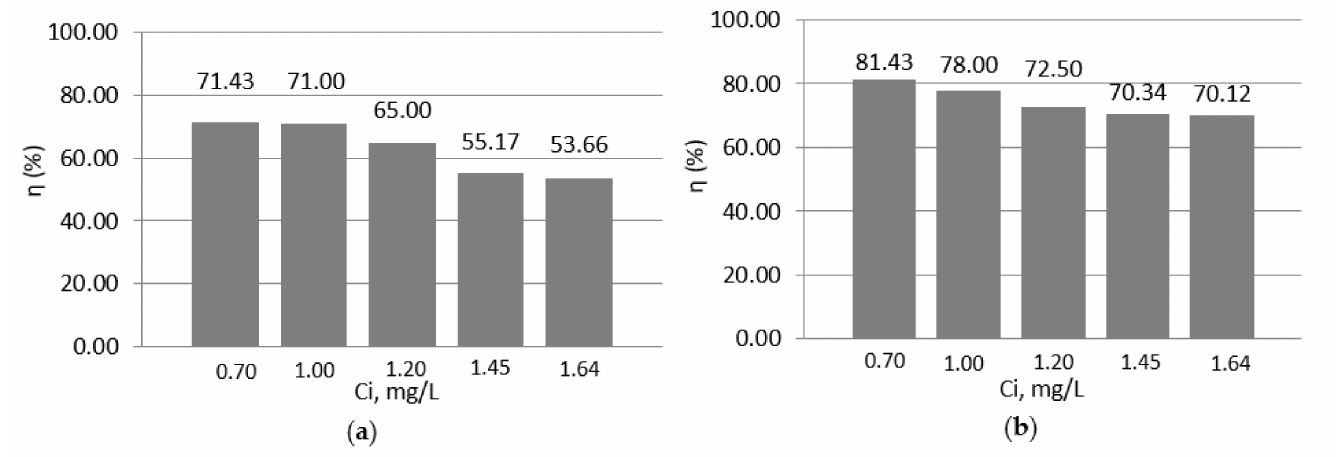
Figure 5. Efficiencies of wastewater treatment at 30 ◦ C versus initial concentrations at pH 4 ( a ) and pH 6 ( b